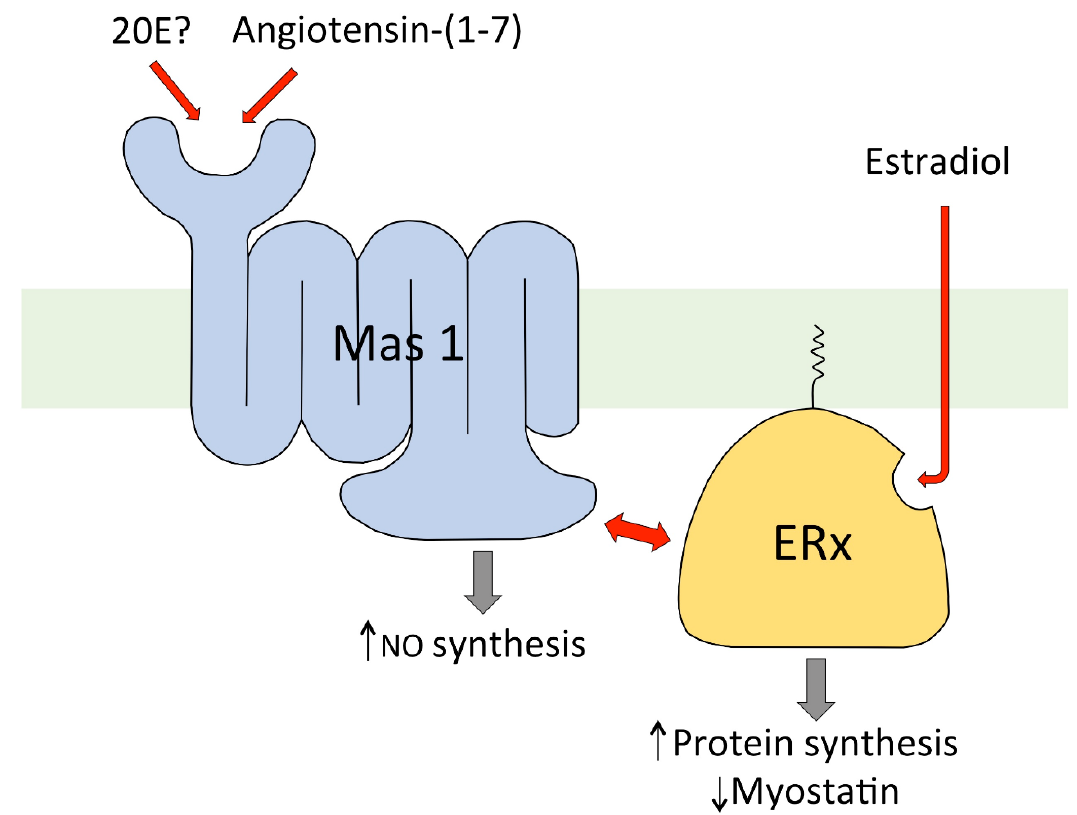
Figure 6. Diagrammatic representation of the proposed mode of action of 20E in the regulation of protein synthesis in C2C12 muscle cells in vitro ([113]).